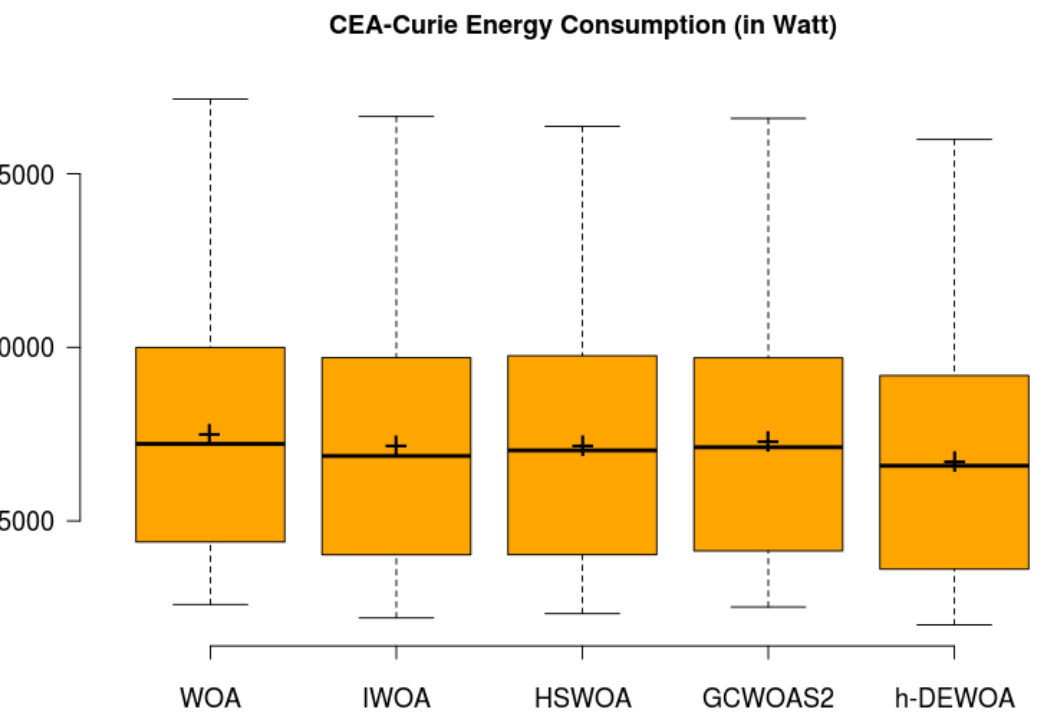
Figure 12. Comparative boxplot analysis of the overall energy consumption of h-DEWOA- and WOA-based scheduling algorithms for CEA-Curie workloads.